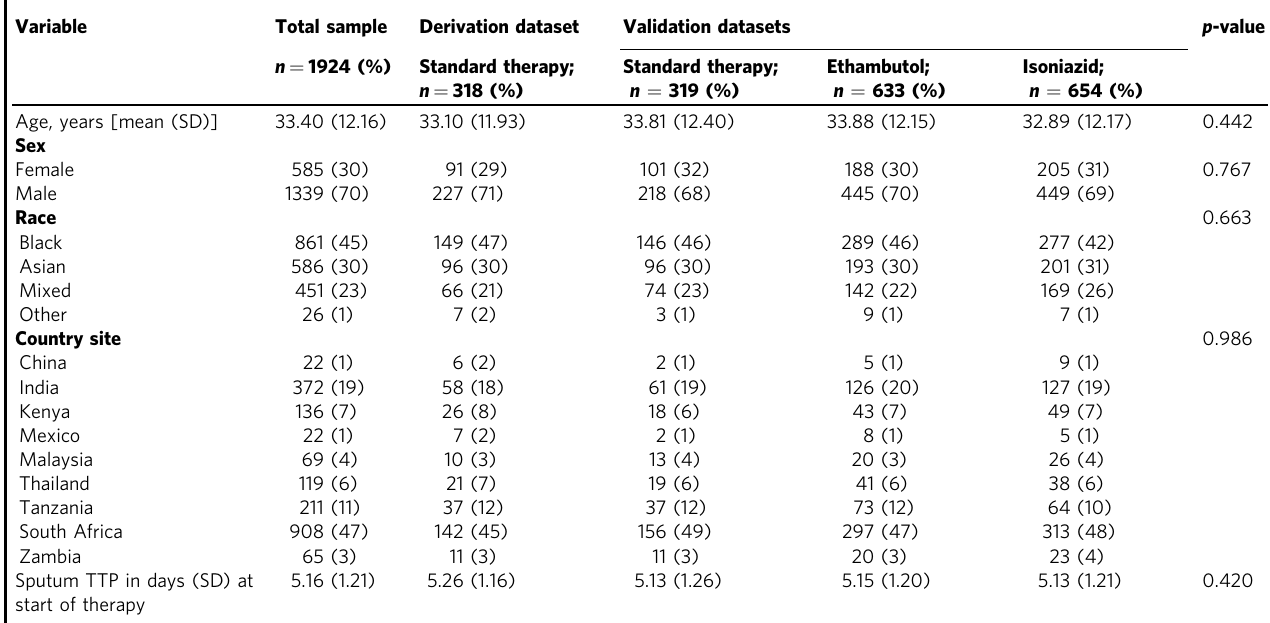
Table 1 Clinical features of patients in derivation and validation datasets.